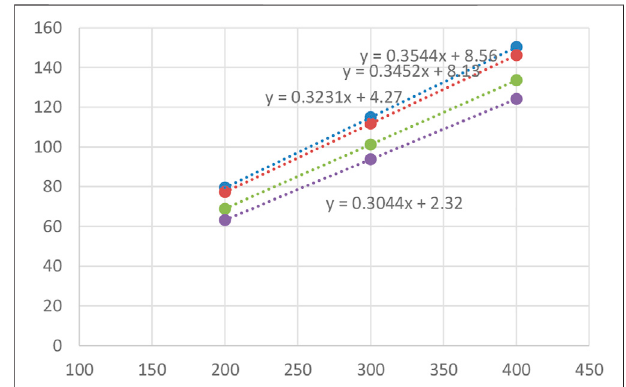
FIGURE 11 | Fitting residual cohesion cr residual internal friction angle φ